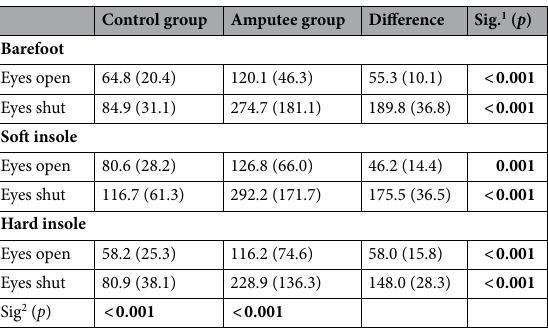
Table 3. Comparison of Length of movement of the barycenter between experimental groups. Significant values are in [bold]. Mean (standard deviation). 1 Mann–Whitney Test. 2 Friedman Test. Length of movement of the barycenter (mm).